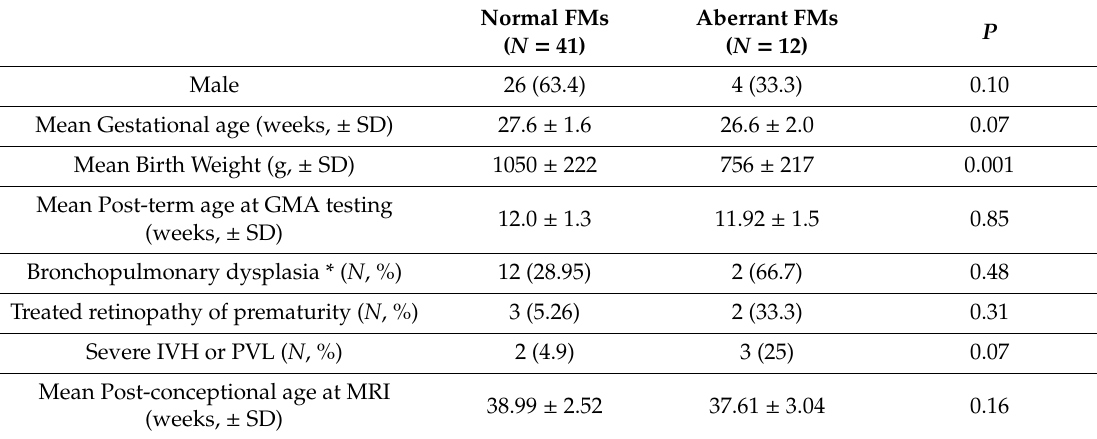
Figure 2. Matrices of mean correlation coefficients between each of the 90 brain regions evaluated in infants with normal and aberrant fidgety movements. Scale bars link the color of each matrix element to the mean correlation coefficient between each region pair. Table 4. Comparison of clinical characteristics of scanned infants with normal and aberrant